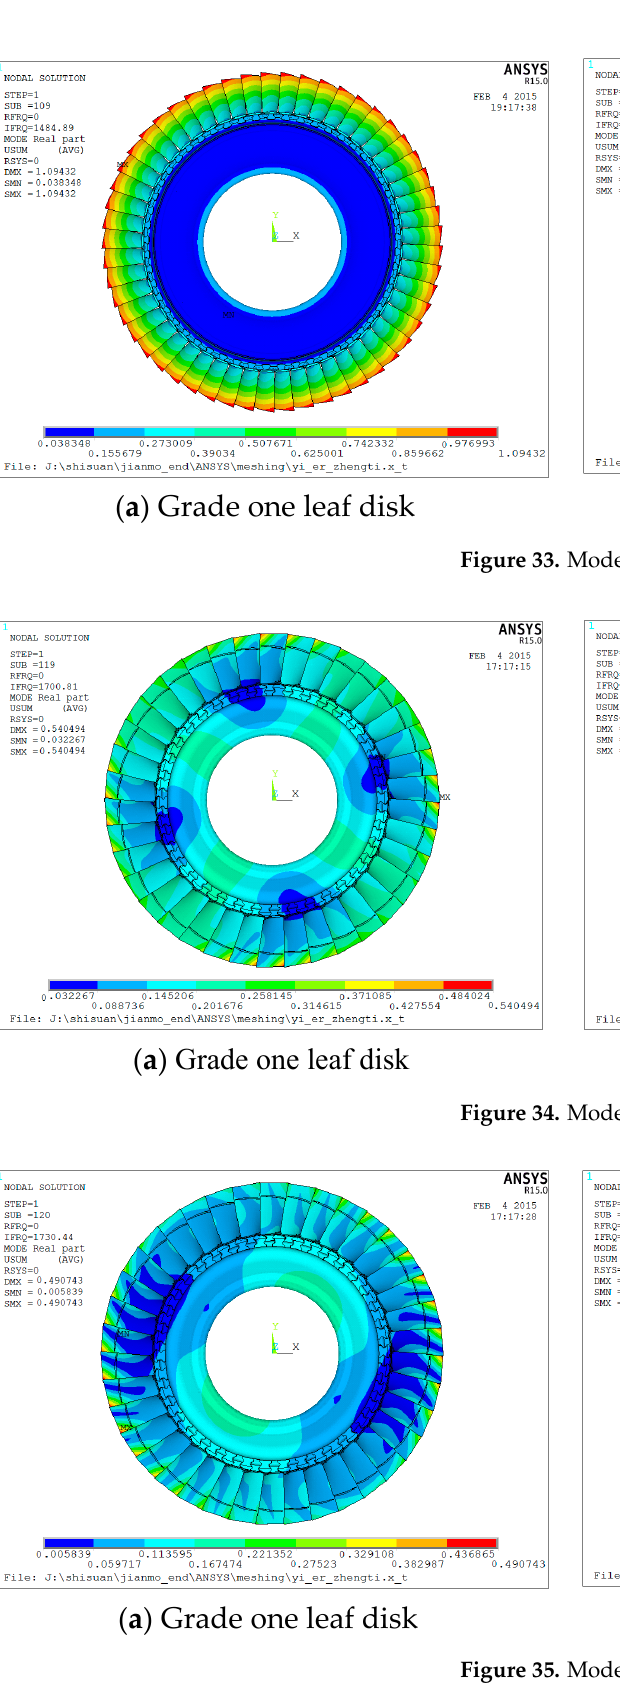
Table 11. Comparison of natural frequencies between the two-stage and single-stage bladed disk coupled systems. Level One